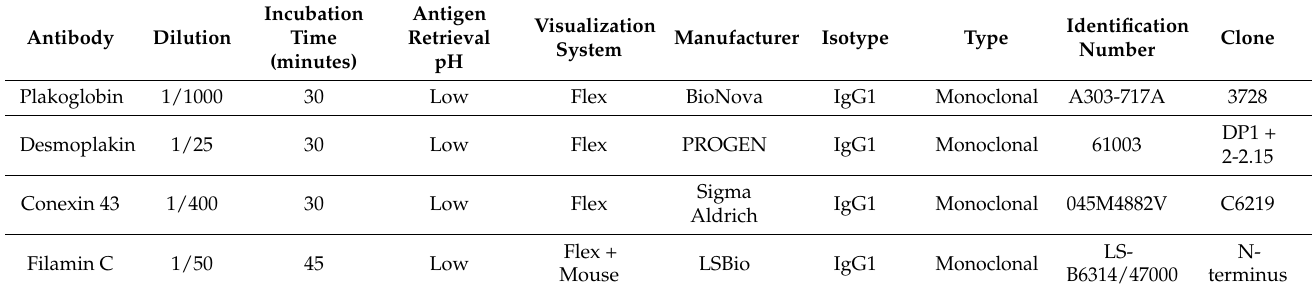
Table A1. Information on the antibodies used in the study as well as on the immunohistochemical procedure. Antibody